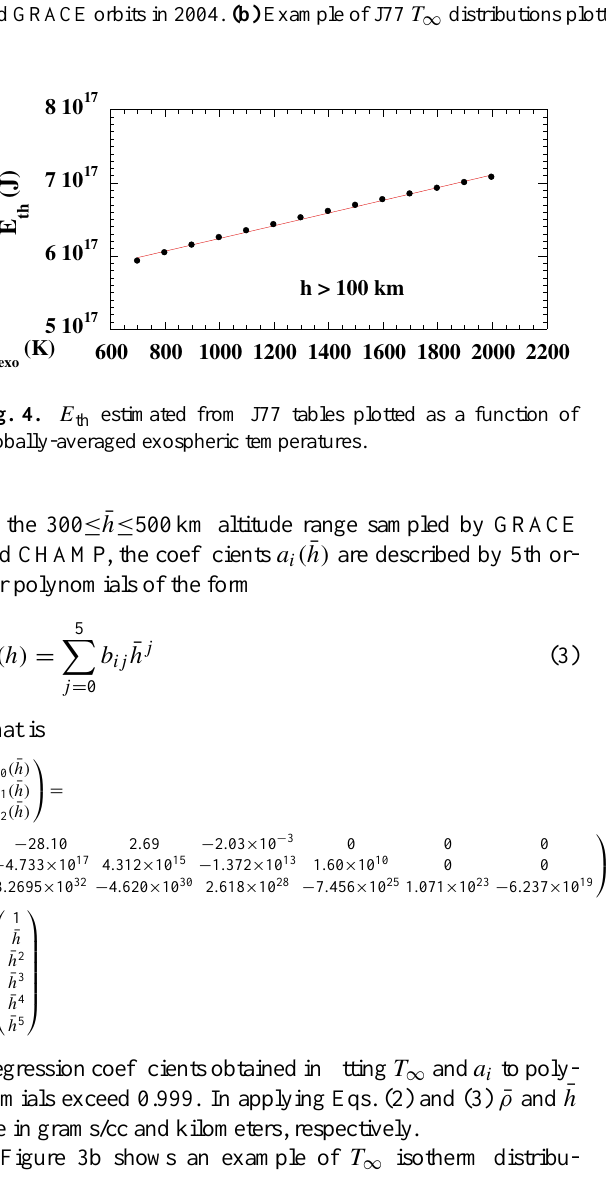
Fig. 3. (a) Mass density profiles as functions of altitude for five selected values of T ∞ . Vertical lines bound the range of altitudes of CHAMP and GRACE orbits in 2004. (b) Example of J77 T ∞ distributions plotted on a latitude and local time grid.